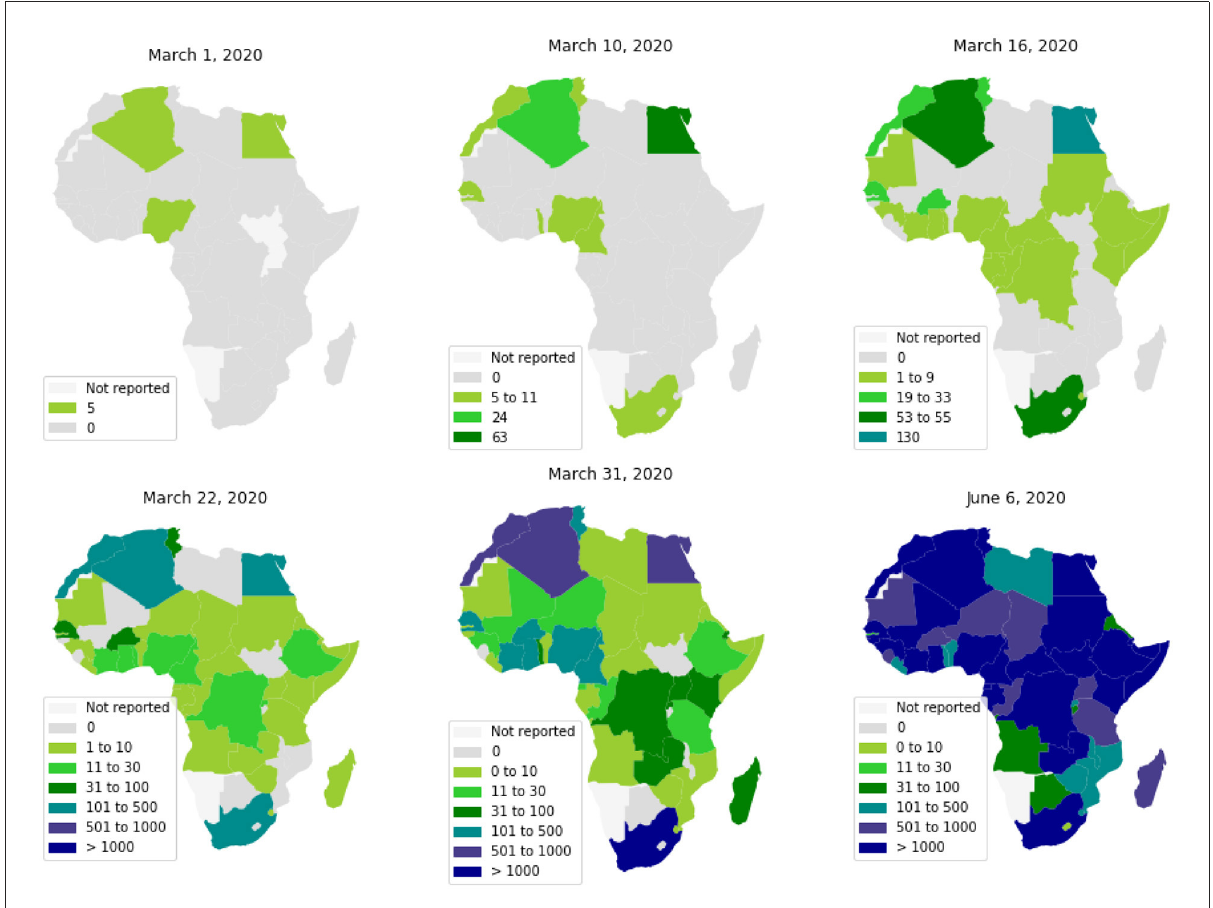
FIGURE1 Spread of COVID-19 in